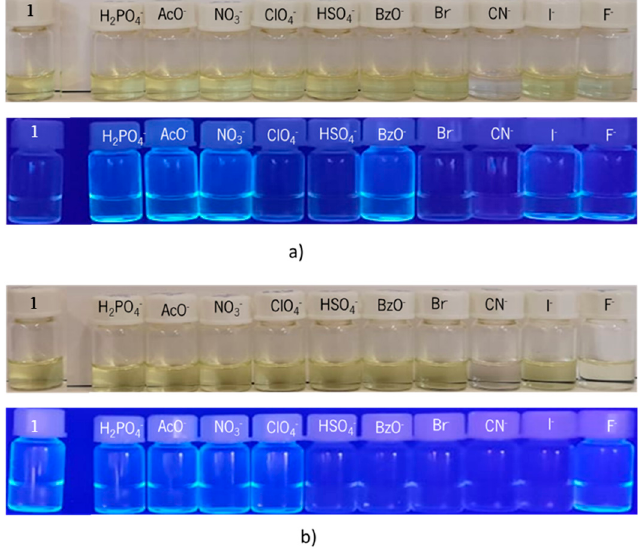
Figure 3. Dicyanovinyl derivative 1 solutions in the presence of various anions: ( a ) in ACN, under natural light (above) and UV radiation at λ max = 365 nm (below); ( b ) ACN/ H 2 O (8:2) under natural light (above) and UV radiation at λ max = 365 nm (below).